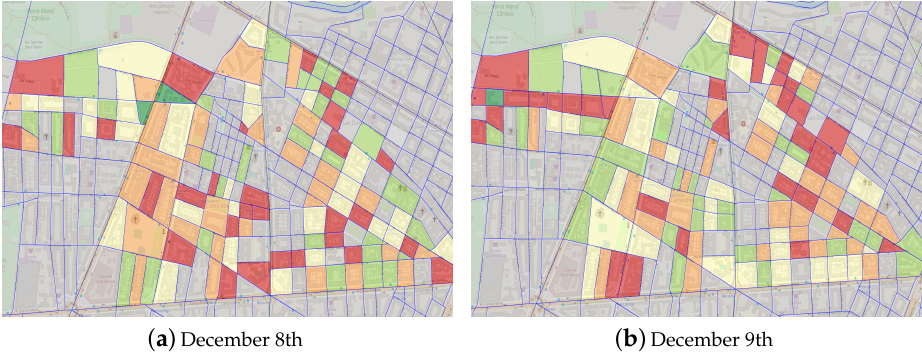
Figure 4. Average consumption per m 3 of the buildings in the monitored district, grouped by